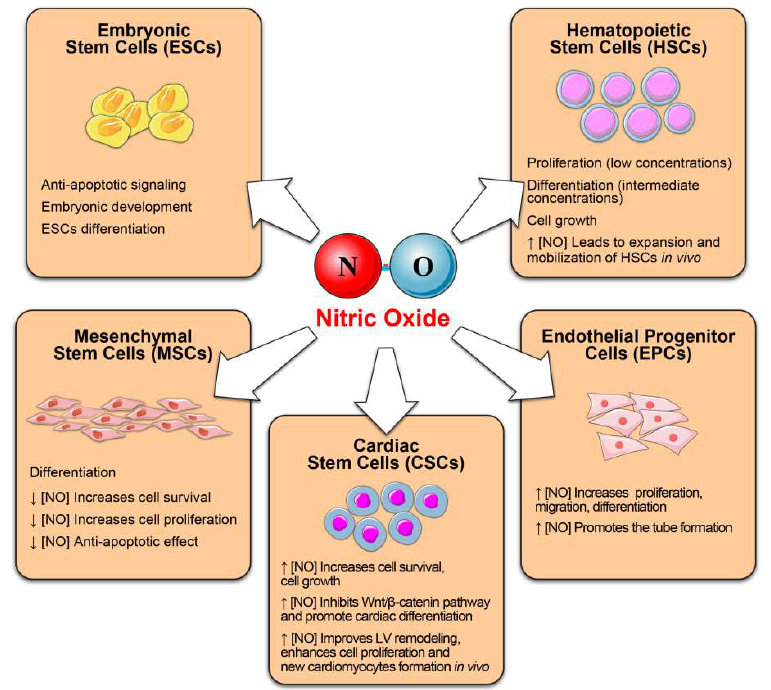
Figure 2. Nitric oxide as regulator of stem and progenitor cell function and fate. We summarize the beneficial effects exerts by NO on several stem cell compartments.